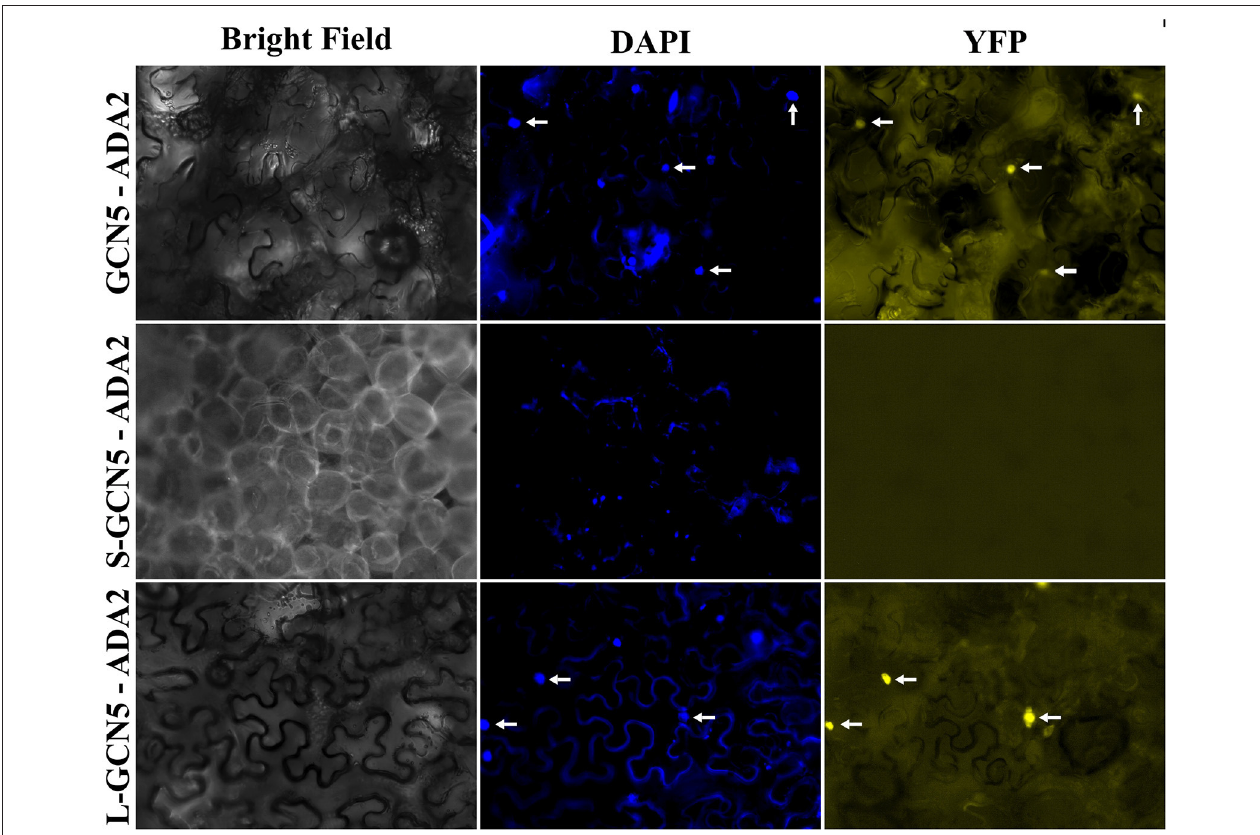
FIGURE 5 | GCN5 and L-GCN5 interact with ADA2 in vivo . Representative images of N. benthamiana epidermal cells infiltrated with A. tumefaciens harboring the pDOE-8 bimolecular fluorescence complementation vector that contained either GCN5, S-GCN5 or L-GCN5, and ADA2. Images of bright field and fluorescence (YFP filter) and following DAPI staining are presented. Arrows indicate nuclei detected under both DAPI and YFP